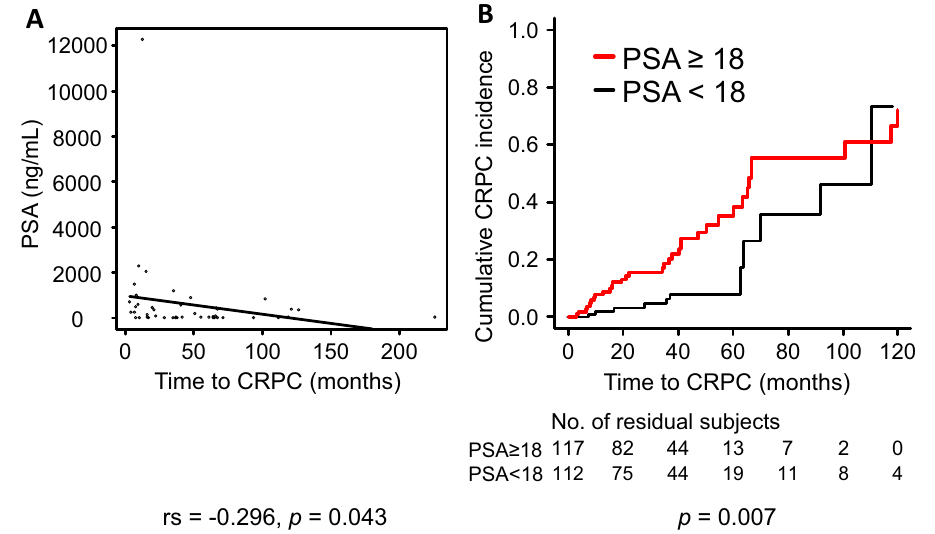
Figure 2. Impact of PSA levels at initial diagnosis on the time to CRPC progression in PC patients undergoing hormone therapy. ( A ) Correlation between PSA levels and the time to CRPC progression. Spearman’s rank correlation coefficient (rs) and p values are shown in the bottom of the graph. Box-and-whisker diagrams for PSA and the time to CRPC progression are shown outside the graph. ( B ) Kaplan–Meier curves show the time- related progression to CRPC in patients with PSA ≥ 18 ng/mL or PSA < 18 ng/mL at initial diagnosis. Statistical differences among groups were analyzed by the log-rank test. p values are shown in the bottom of each